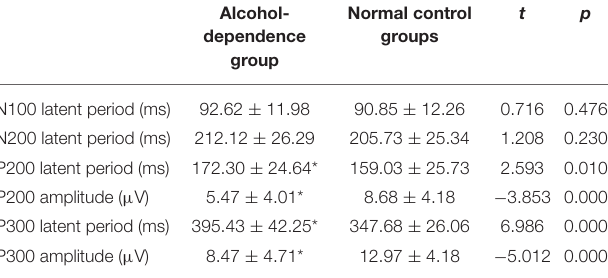
TABLE 4 | Comparison of event-related potentials between the alcohol-dependence group and normal control groups (mean ± SD).